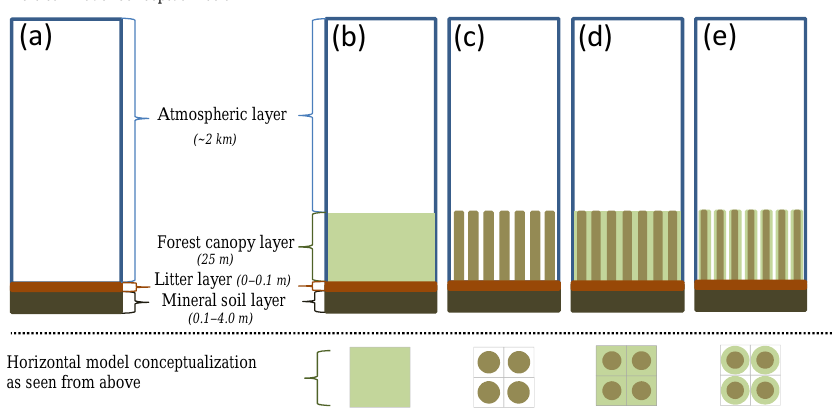
Figure 2. Model conceptualizations of forest. (a) no forest canopy layer (model name: No vegetation; (b) homogeneous foliage layer with a uniformly distributed biomass (model name: Foliage); (c) cylindrical tree trunks with air in between (model name: Tree trunk, Air); (d) cylindrical tree trunks with foliage in between (model name: Tree trunk, Foliage, Air); (e) cylindrical tree trunks enveloped in a foliage cover with air in between (model name: Tree trunk, Foliage, Air). The bottom four figures illustrate the forest conceptualization seen from